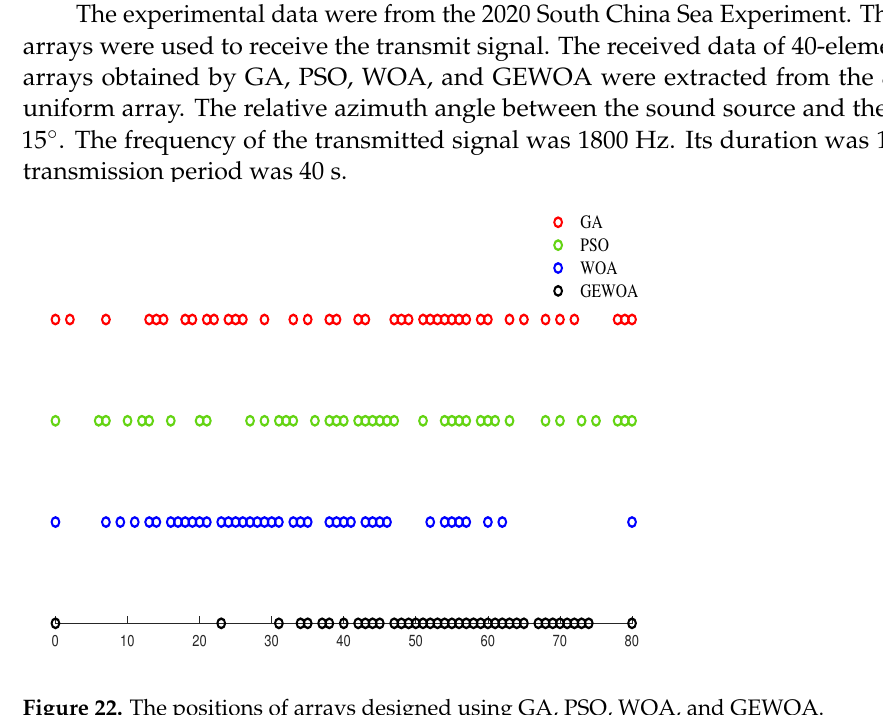
Figure 22. The positions of arrays designed using GA, PSO, WOA, and GEWOA.